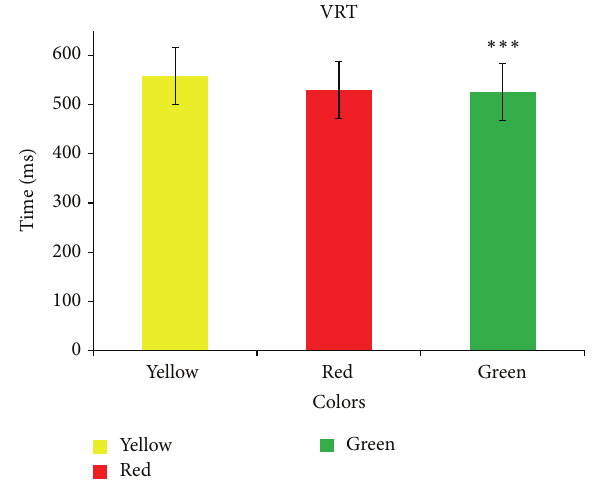
Figure 1: Comparison of visual choice reaction time among colors. Values are expressed as mean ± SD; analysis was done by repeated measures ANOVA. ∗ 𝑃 < 0.05 ; ∗∗ 𝑃 < 0.01 ; ∗∗∗ 𝑃 < 0.001 . 𝐹 value, 15.01. VRT: visual reaction time.